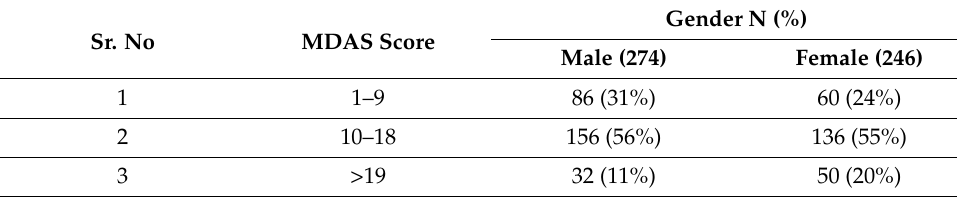
Table 2. Dental Anxiety scores according to Gender.